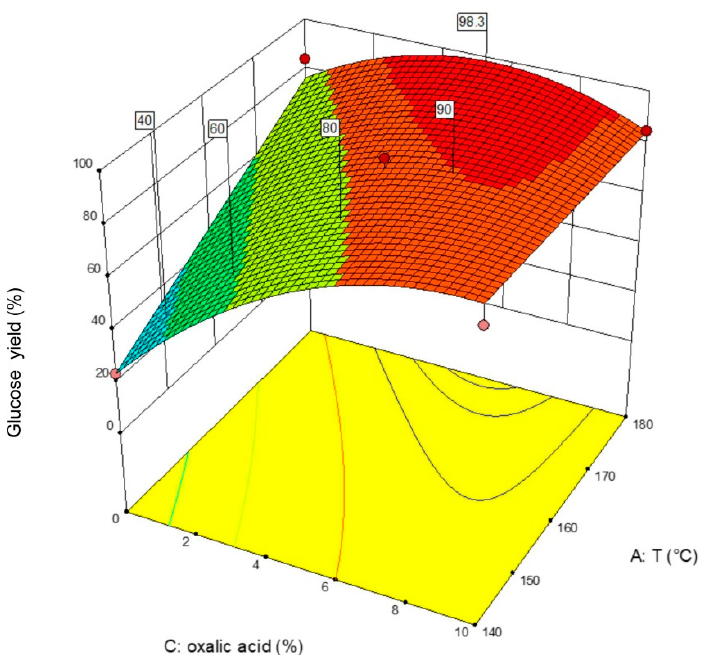
Figure 6. Recovery yield of glucose from WS pretreated with butanol as a function of temperature and oxalic acid (time = 90 min) .